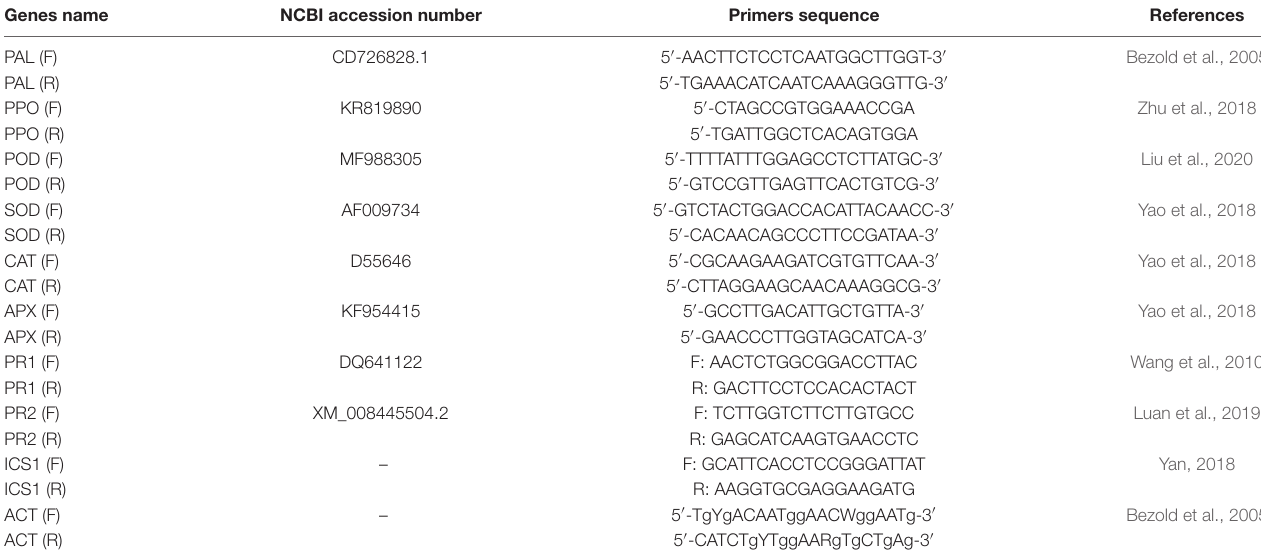
TABLE 1 | Gene-specific PCR primers for target genes and Actin